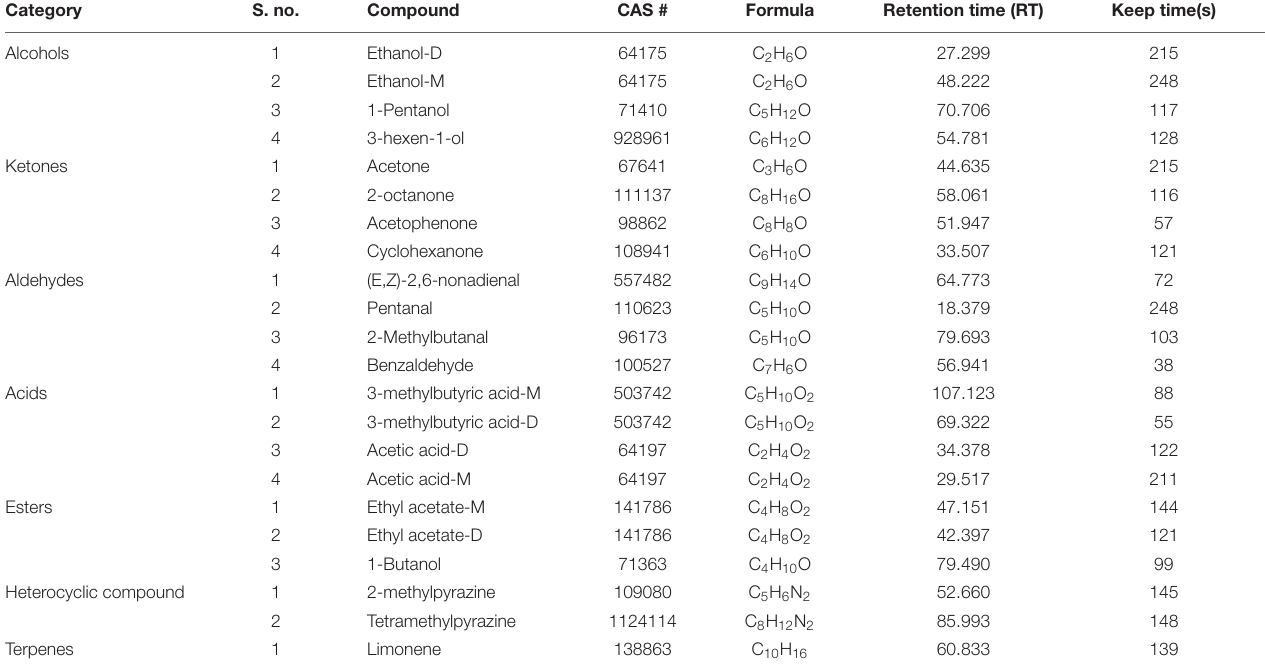
TABLE 1 | Qualitative properties of volatile compounds in aspartame dried products. Category S. no. Compound CAS # Formula Retention time (RT) Keep